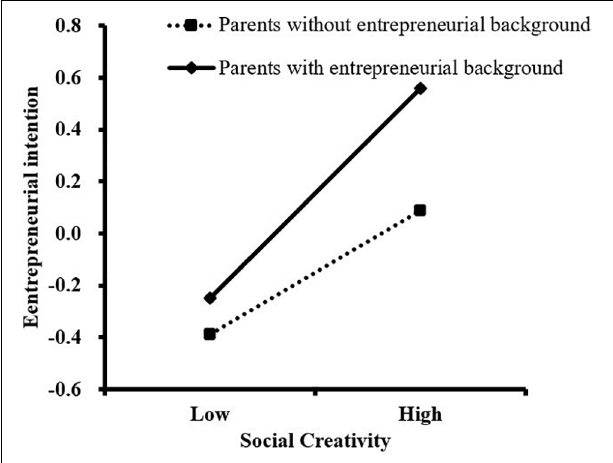
FIGURE 2 | The moderating effect of parental entrepreneurial background on the relationship between social creativity and entrepreneurial intention.